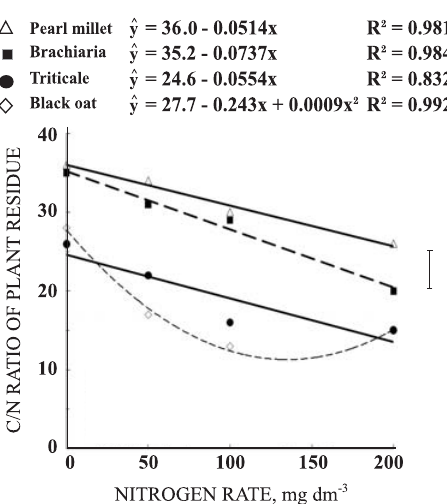
- (b) leaching from cover + (a) and NO Figure 5. C/N ratio of the shoot dry matter of Figure 3. N-NH 4 3 different cover grasses as related to N crop plant residues after simulation of 30 mm fertilization. Vertical bar show LSD comparing rainfall as related to N fertilization. Vertical bar species (p ≥≥≥≥≥ 0.05). ** R 2 significant (p ≤≤≤≤≤ 0.001); show LSD comparing species (p ≥≥≥≥≥ 0.05). ** R 2 ns R 2 non significant (p ≤≤≤≤≤ 0.001); ns R 2 non significant.